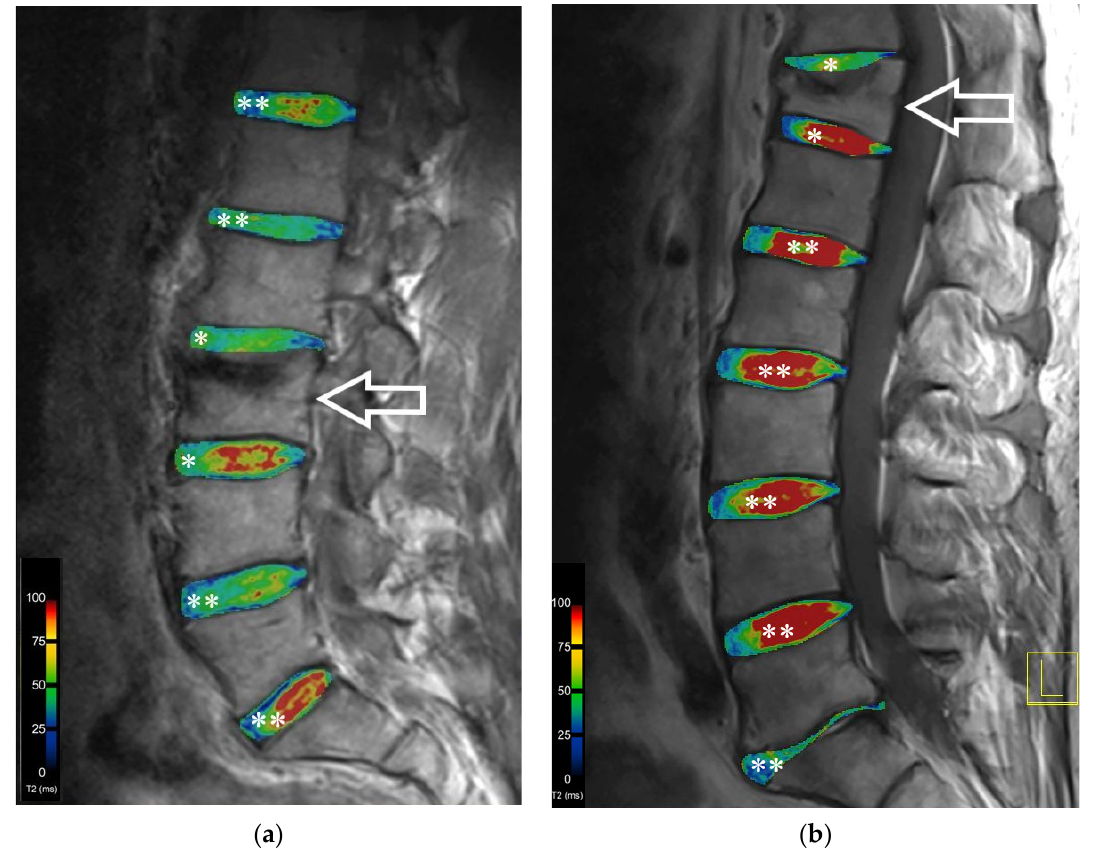
Figure 4. Sagittal TSE MR image and the corresponding colour-coded T2 map of the intervertebral disc. Sagittal TSE MR image and the corresponding colour-coded T2 map of the IVD of two different patients (( a ) female, ( b ) male) show clearly visible differences between the upper intervertebral discs adjacent (*), especially upper IVD, and nonadjacent (**) to vertebral bodies after kyphoplasty. The arrow marks the vertebral body treated with kyphoplasty. The T2 values are represented by the colour-coded map within the IVDs, as shown in the colour bar.